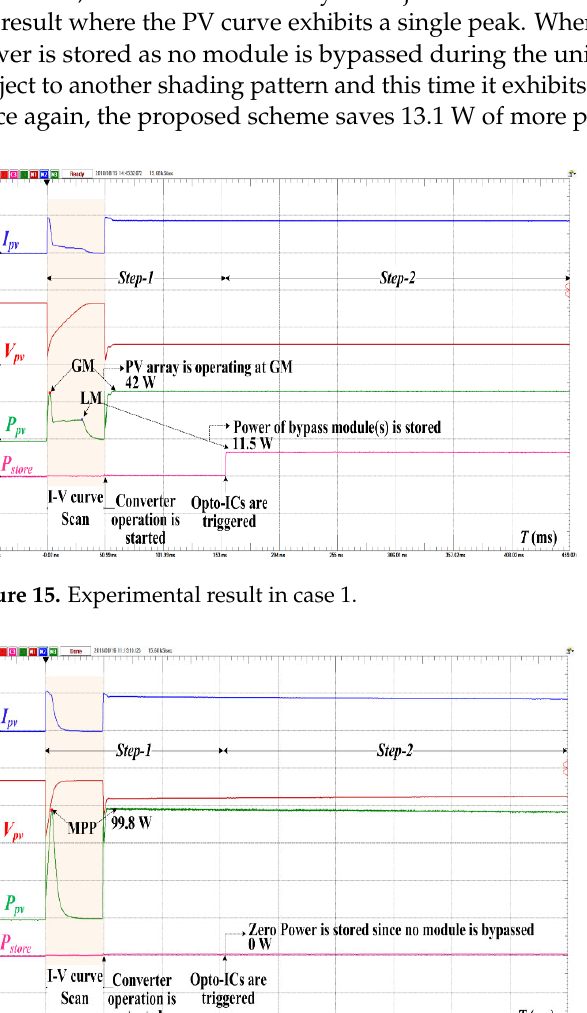
Figure 16 . Experimental result in case 2 .